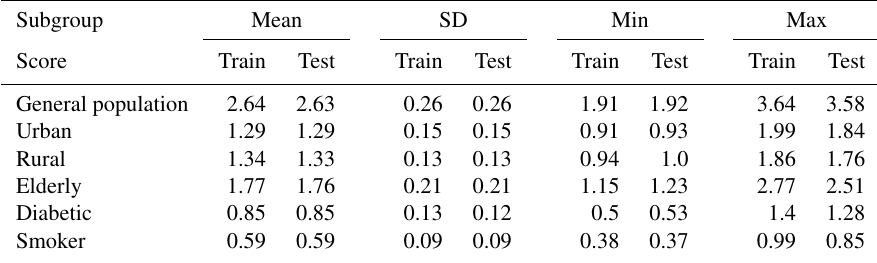
Table A8. Daily mean, standard deviation, and minimum and maximum predictions across models for each